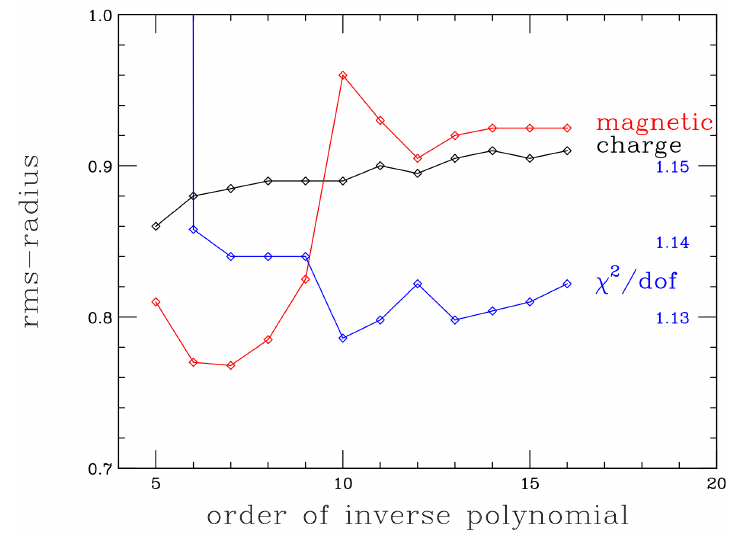
Figure 6. Charge and magnetic rms-radius from the inverse polynomial fit, together with the χ 2 per degree of freedom (right-hand scale)